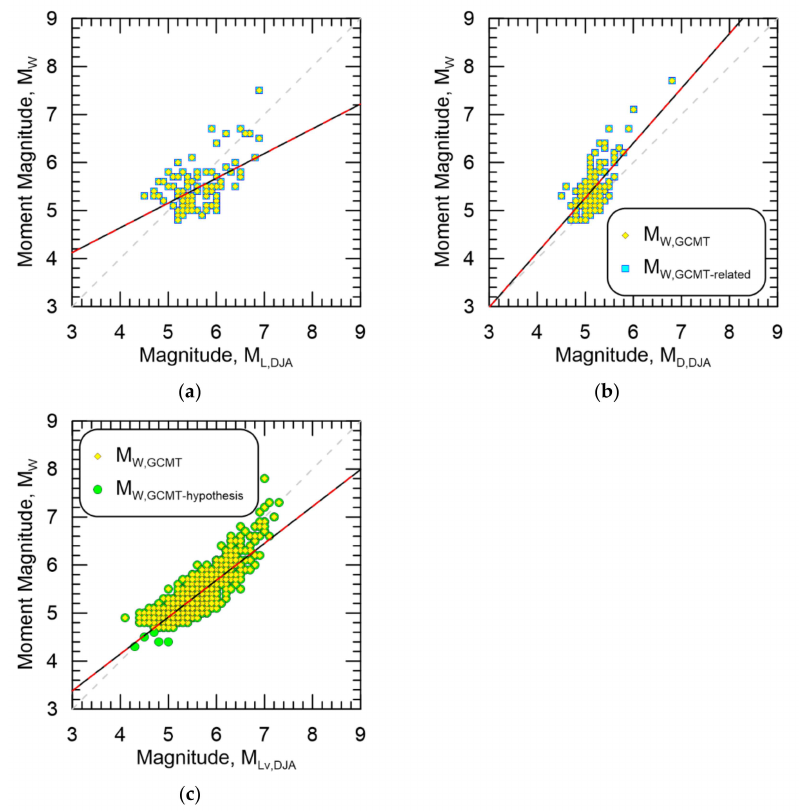
Figure 8. Resultant magnitude homogenization regressions for M W,GCMT-related against ( a ) M L,DJA , ( b ) M D,DJA , and M W,GCMT-hypothesis against ( c ) M Lv,DJA . Data from M W,GCMT are also shown. Black line is the regression against M W,GCMT-related or M W,GCMT-hypothesis while the dashed red line is the regression against M W,GCMT